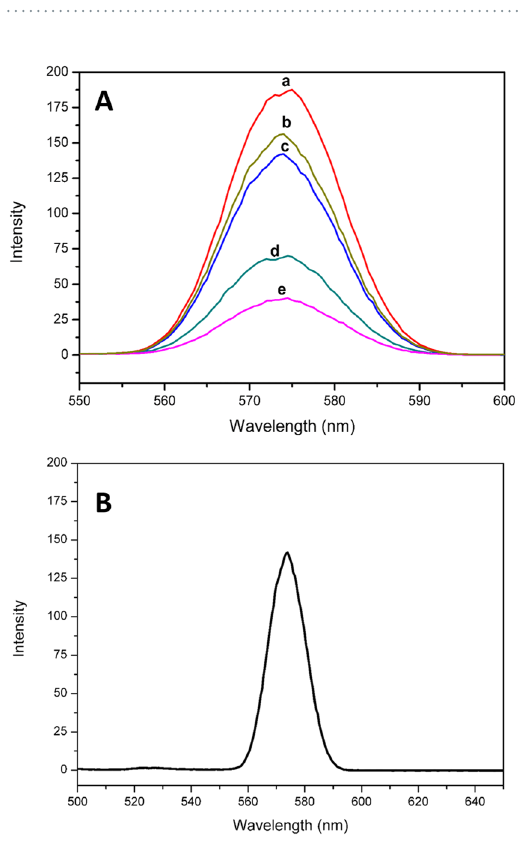
Figure 10. ( A ) PL measurements of (a) platelet-like BiVO4, (b) 3-2 Bi:Ti (PM), (c) 1–1 Bi:Ti, (d) 2–3 Bi:Ti and (e) 3-2 Bi:Ti. ( B ) PL measurement of